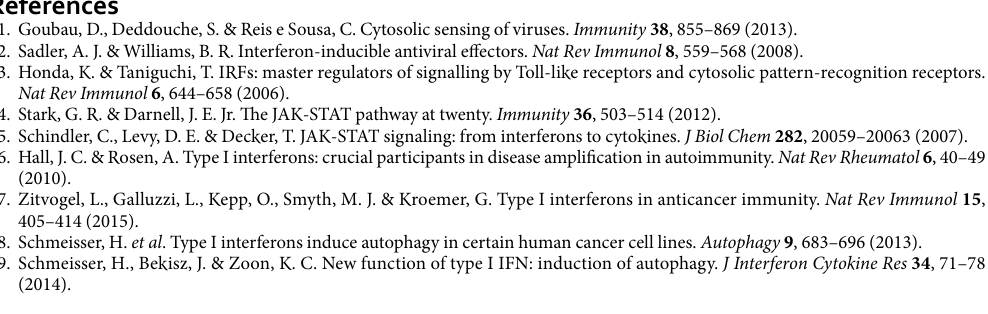
pathway, thus suggesting an interplay between autophagy and ATF3 20, 21 . We observed enhanced autophagy in ATF3-depleted cells and found several autophagy-related genes to be highly induced following JEV infection in ATF3-depleted neuronal cells. Further, we found the autophagy-related gene Atg5 as a transcriptional target of ATF3.There may be additional ATF3 targets among the autophagy-related genes, as many of these had a putative ATF3 binding site but remain to be validated by ChIP assay. Cellular antiviral and autophagy responses are known to have antiviral effects. Here, we show that ATF3 is a negative regulator of cellular antiviral and autophagy processes. Accordingly, ATF3 depletion led to a signif- icant inhibition of JEV replication in neuronal as well as fibroblast cells. Thus, induction of ATF3, leading to suppression of cellular antiviral and autophagy response, might be exploited by the virus to facilitate its life cycle. Similar findings were made in the case of Lymphocytic Choriomeningitis virus (LCMV) which showed a marked reduction of virus replication in Atf3 KO BMDMs 29 . Interestingly, however, Coxsackievirus B3 infection of HeLa cells caused suppression of ATF3 expression 45 . Interestingly, Coxsackievirus B3 has been shown to utilize cellular autophagy pathway for its efficient replication suggesting that virus has evolved to inhibit ATF3, thereby inducing autophagy which is beneficial for its replication 50 . On the contrary, ATF3 expression was increased in the livers of mice infected with Murine cytomegalovirus (MCMV) and a striking reduction in viral load was seen in the livers of Atf3 KO mice relative to WT mice which was attributed to increased IFN-gamma in Atf3 KO mice 43 . In summary, we have presented evidence to show ATF3 as a negative regulator of antiviral response and auto- phagy in mammalian cells (Fig. 9) during JEV infection thereby providing an advantage for the virus to propa- gate. Importantly, we provide evidence for the type I IFN-independent action of ATF3 in regulating the antiviral genes using the Stat1-Irf9 axis and the regulation of the cellular autophagy through Atg5 . This highlights the potential of targeting ATF3 for controlling the JEV replication, although the important role of ATF3 in regulating the cytokine responses cannot be overlooked.